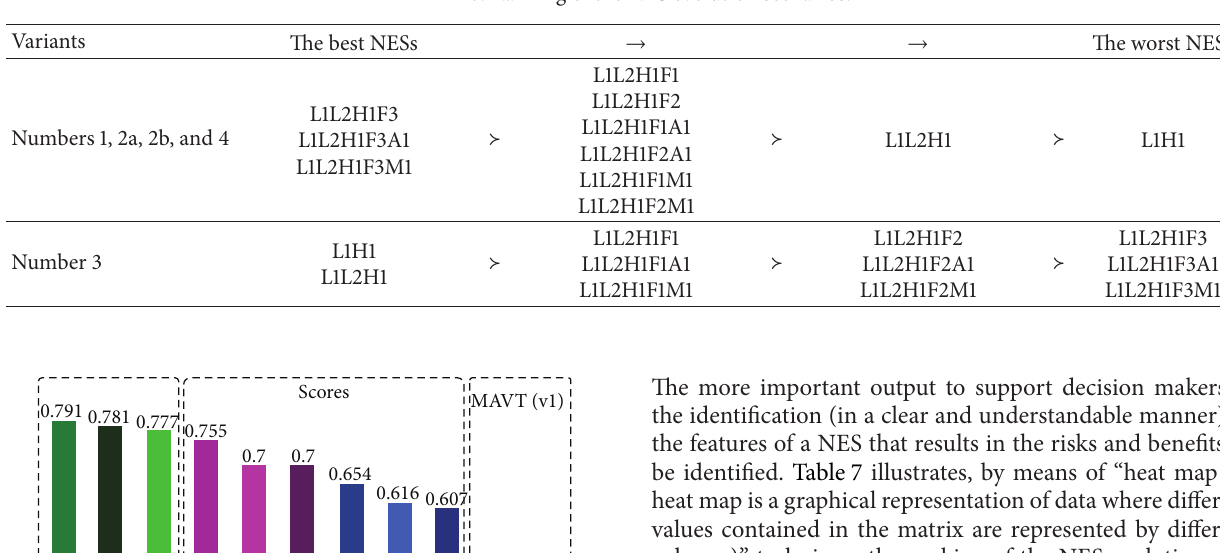
Table 6: Ranking of the NES evolution scenarios.